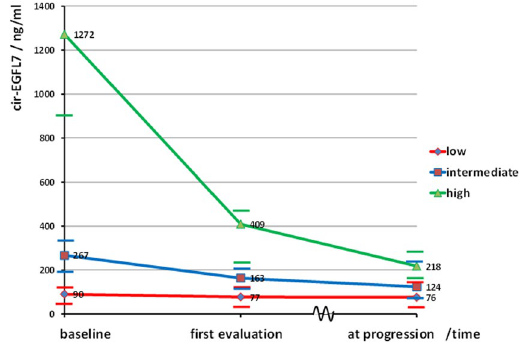
Figure 1. Median circulating epidermal growth factor-like domain 7 (cir-EGFL7) according to baseline levels (lowest third, intermediate third, and highest third) at baseline, first evaluation, and progression. Horizontal lines mark the respective upper and lower limits of the 95% confidence intervals (CI). The upper limit (2003 ng/ ml) of the 95% CI for the high cir-EGFL7 levels at baseline is censored for graphical reasons, but not from the analyses. The broken time line between first evaluation and progression indicates that this time period varies between the patients. The differences between the medians for the low, intermediate, and high groups were significant at baseline and at first evaluation but not at time of progression (p < 0.05).